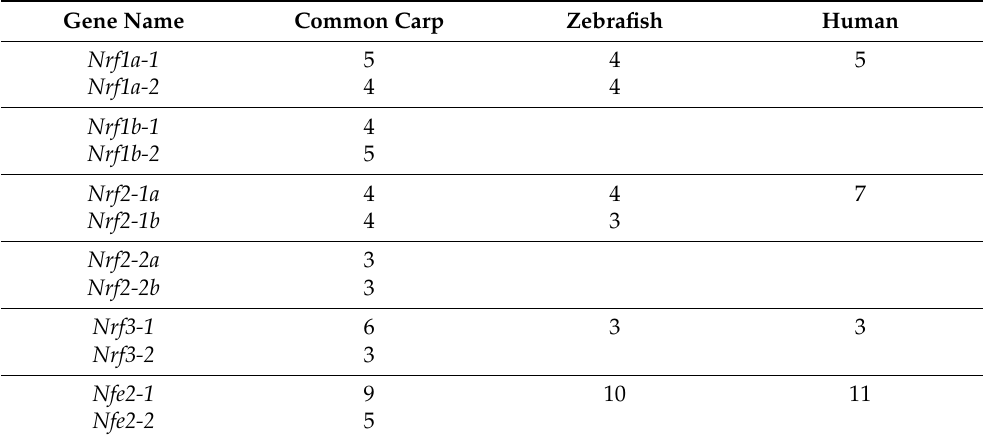
Table 3. Comparison of the exon-intron organization of Nrf genes in common carp, zebrafish, and human.